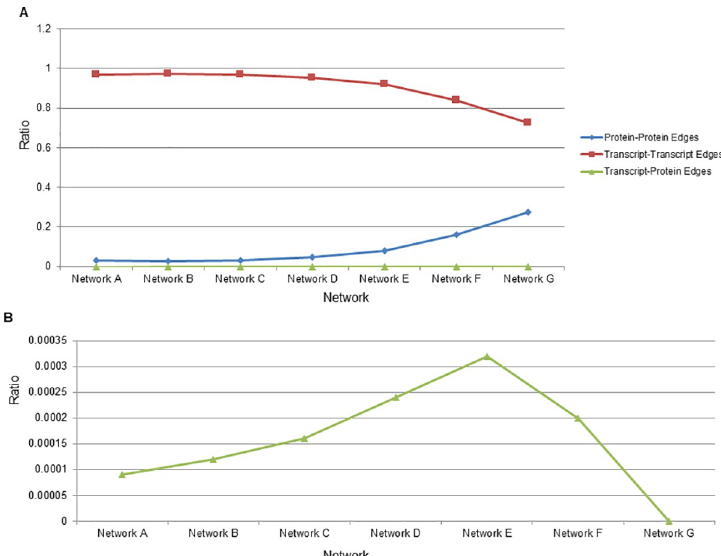
Fig 1. Ratio of edges types by Pearson correlation coefficient to all existing edges of that type. (A) The network letter is indicated on x-axis and the ratio of the number of edges of a particular type (either Transcript-Transcript, Protein-Protein, or Transcript-Protein) to the total number of edges of all types is shown on the y-axis. Network A is the largest and network G the smallest. Protein-Protein ratios are represented by blue diamonds, Transcript-Transcript ratios are represented by red squares and Cross-type edges (Transcript-Protein) are represented by green triangles. (B) Cross-type edge ratios are enlarged for ease of viewing. Network G inferred with Pearson had no cross-type edges so the resulting ratio is